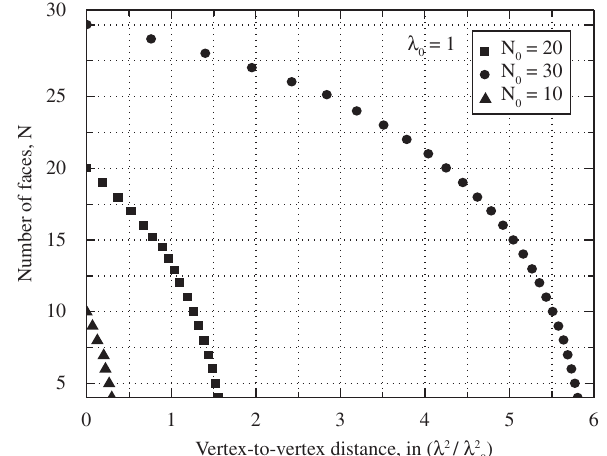
Figure 3. Number of faces of a grain, N, as a function of vertex-to-vertex distance, λ , for different values of the initial number of faces, N initially larger number of faces take a much longer time, i.e., larger increase in λ , to